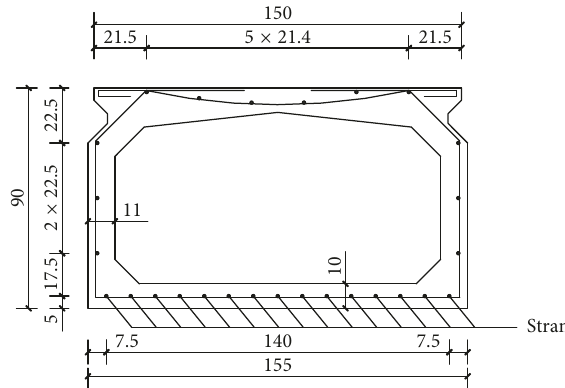
Figure 1: Wide prefabricated concrete hollow slab midspan section